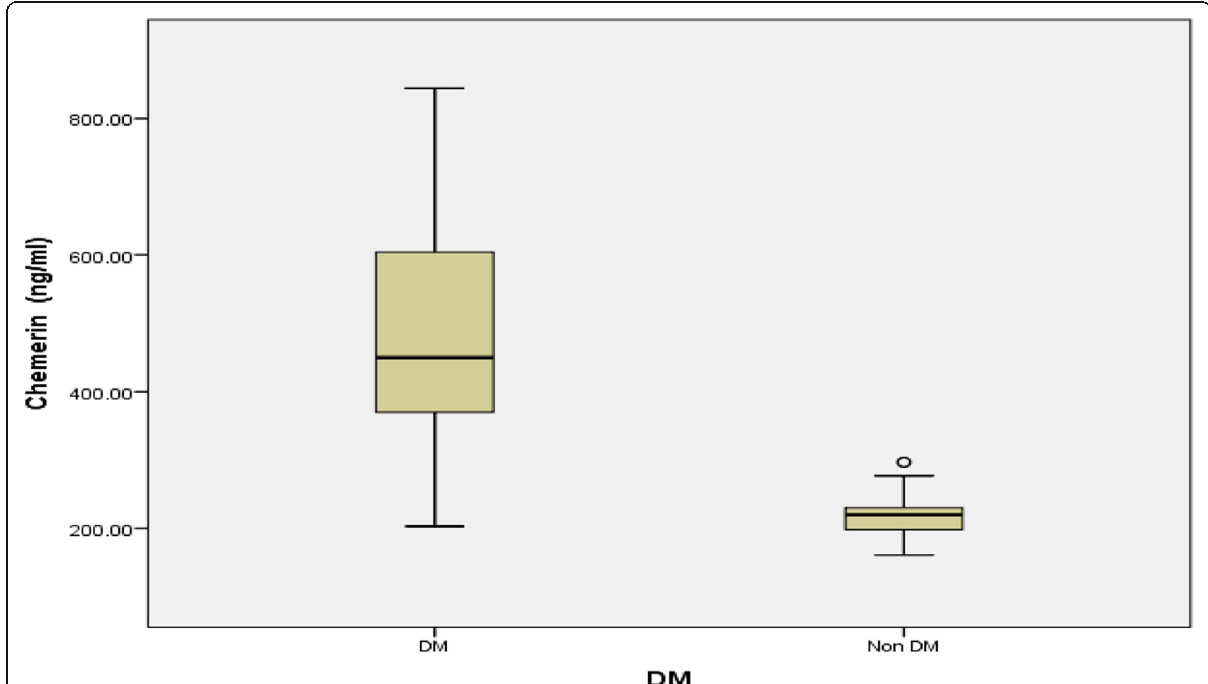
Fig. 1 Box plot between diabetic (T2DM) and non-diabetics (non-DM) according to serum chemerin levels